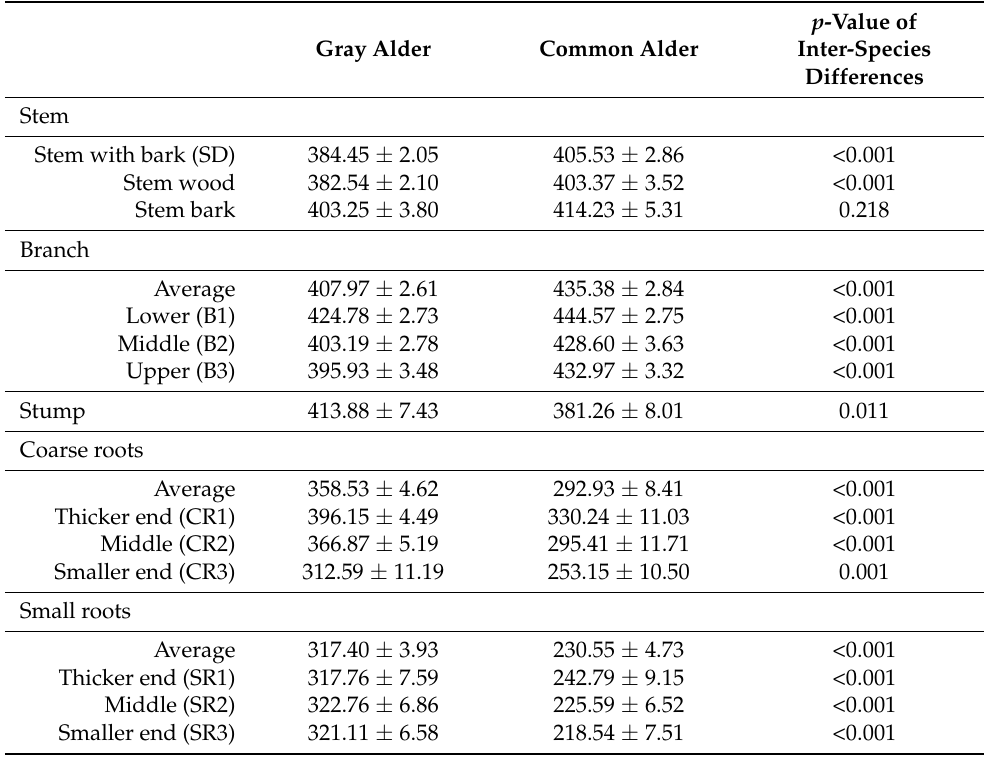
Table 2. Average (mean ± standard error) basic density (in kg m − 3 ) for the aboveground and belowground tree components of gray alder and common